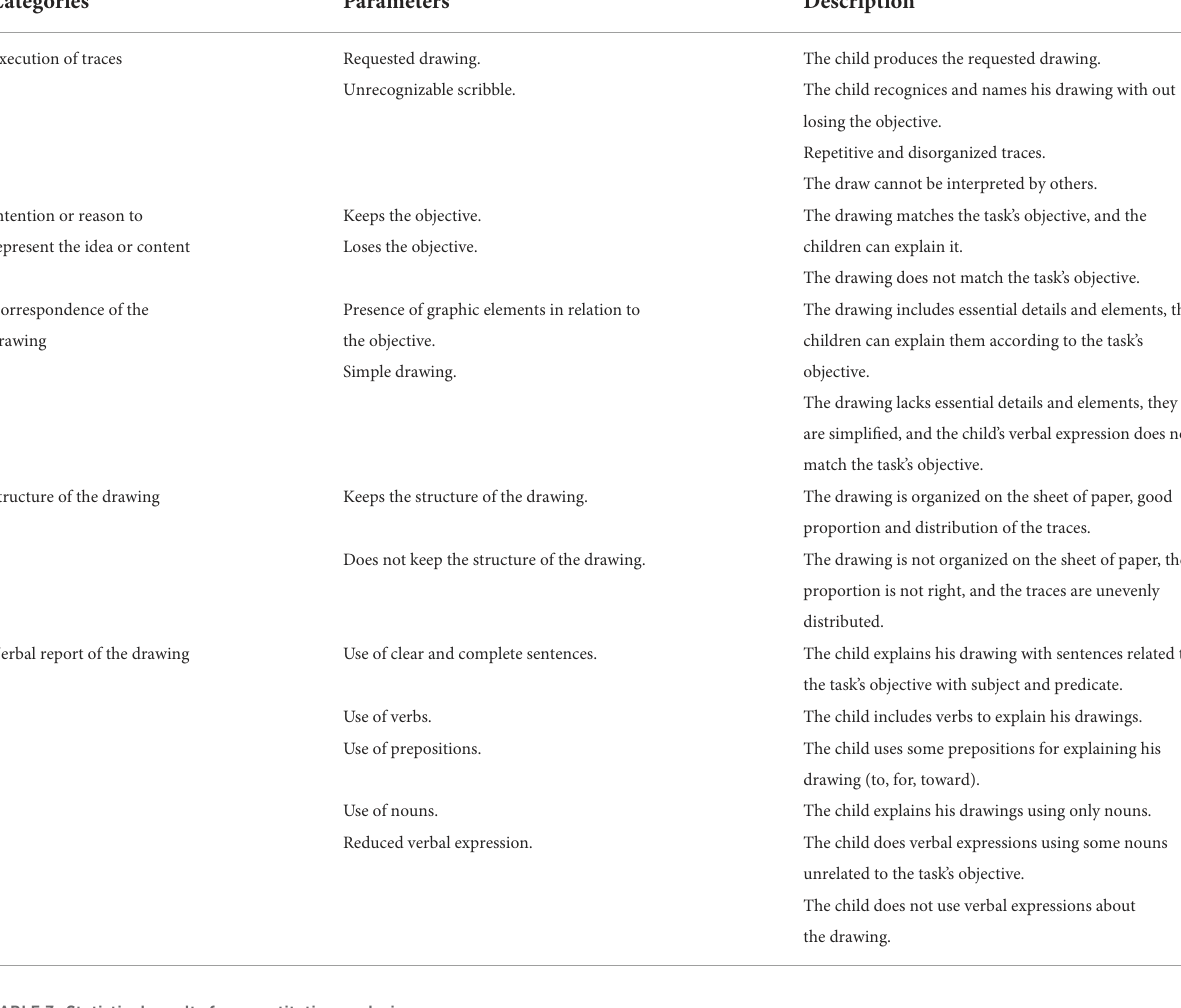
TABLE 2 Categories and parameters for the qualitative analysis of the drawings.